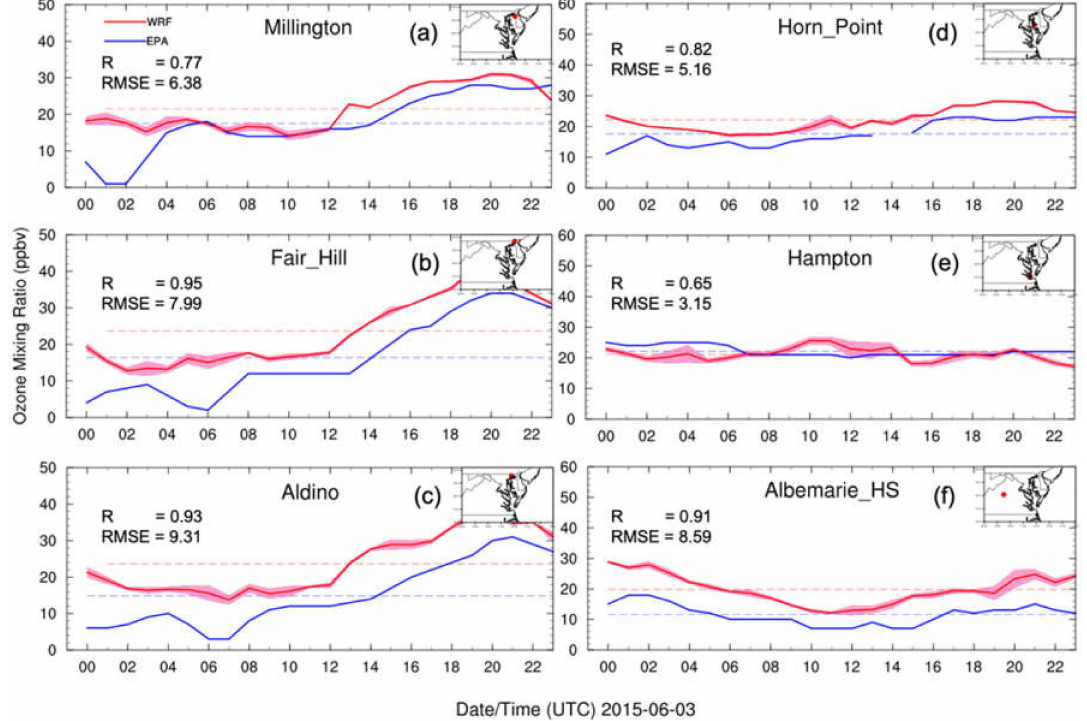
Figure 6. Hourly surface O 3 mixing ratio diurnal variations from EPA AirNow observations (blue curves) and WRF–Chem simulations (red curves) at three AirNow sites. The light-red shaded areas are standard deviations. Surface O 3 mixing ratio daily averages are denoted as dashed lines for AirNow (blue) and WRF–Chem (red). R is the Pearson correlation coefficient and RMSE is the root mean square error. The inset on the upper right shows the locations of EPA AirNow